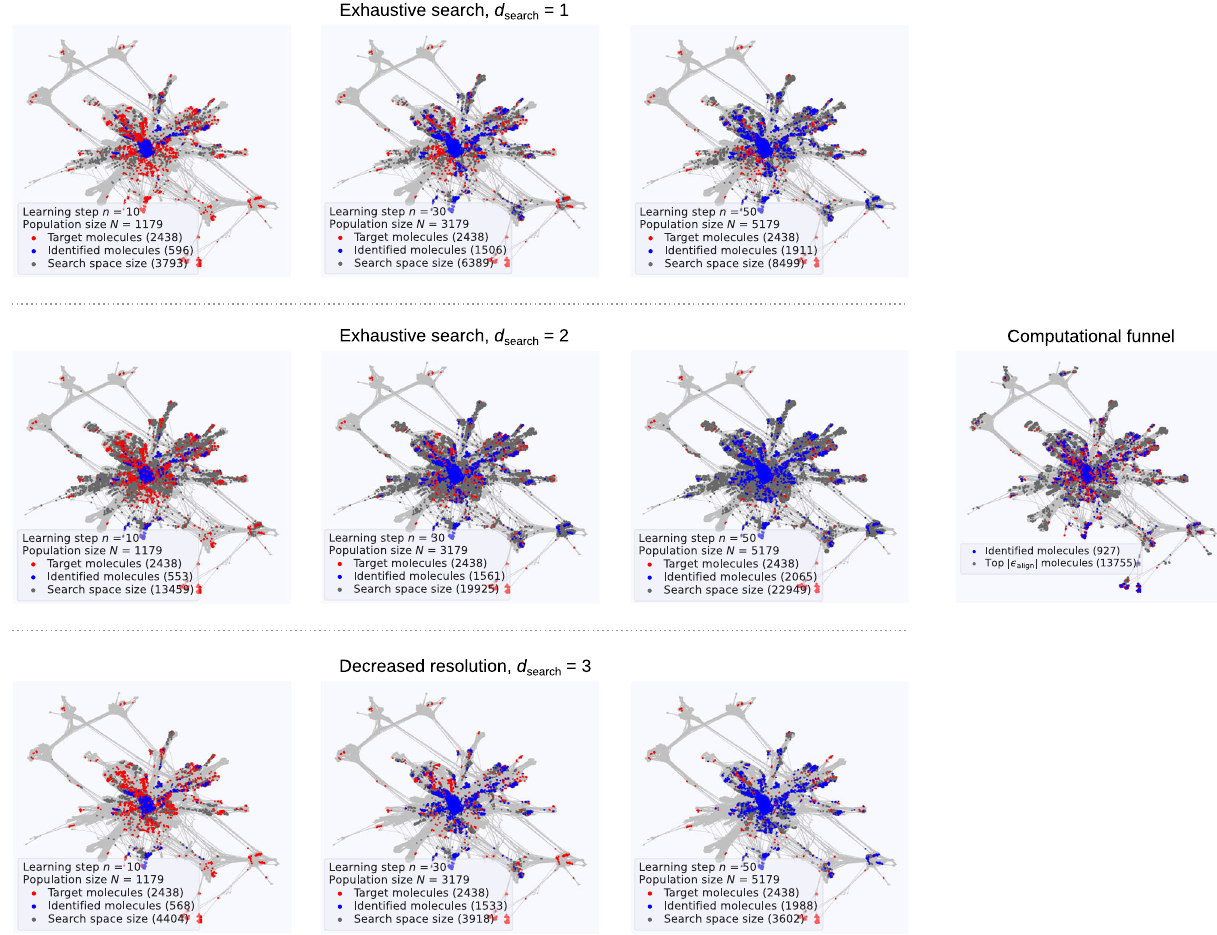
Fig. 3 AML exploration of the fi nite test space. The same CSN representation of the OSC test space as in Fig. 2 is shown in gray. Superimposed are the target group of 2438 top-performing molecules in red. Each panel shows the discovery success after n learning steps with the color of all identi fi ed top- performing molecules changed to blue and the search space for the next learning step n + 1 colored in dark gray. Left upper panels: Steps n = 10, 30, 50 for an exhaustive search with search depth of one. Left middle panels: Steps n = 10, 30, 50 for an exhaustive search with search depth of two. Left lower panels: Steps n = 10, 30, 50 for a decreased resolution search ( N deep = 500) with search depth of three (see text). Supplementary Movies 1 – 3 provide the detailed, full trajectory of all three AML discovery runs over learning steps 1 – 50. Right centered panel: Discovery success of a conventional computational funnel after computing an equal number of descriptors (5179) as after 50 learning steps, and anticipating that knowledge of 13.755 molecules with optimum ∣ ϵ align ∣ < 0.3 eV is present (see